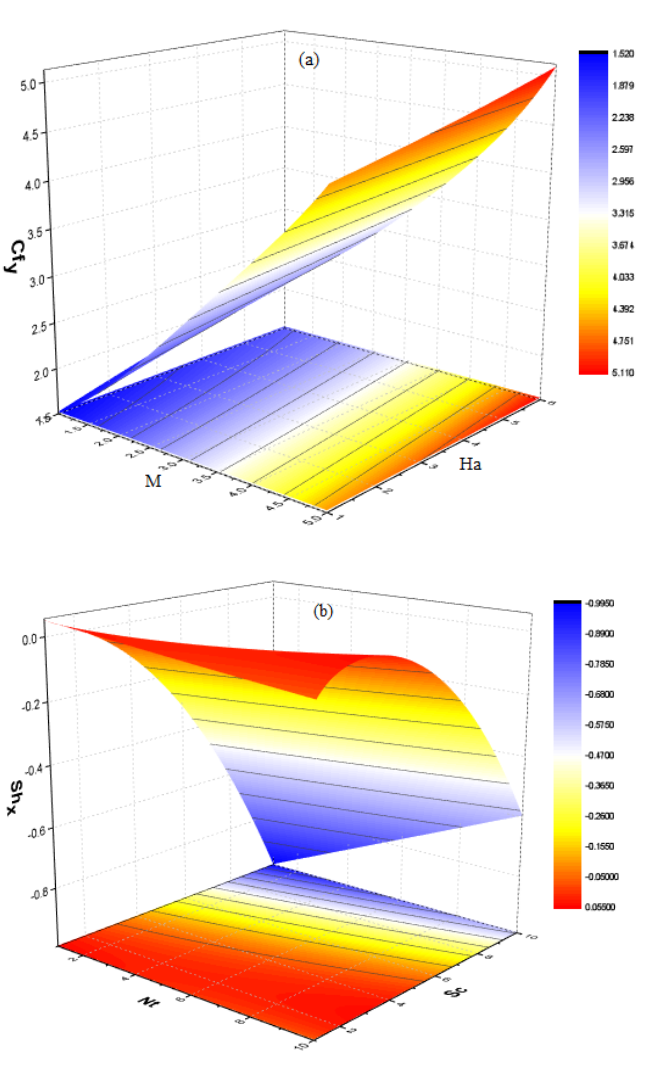
Figure 22. ( a ) Influence of Ha on skin friction. ( b ) Influence of Sc on Sherwood number. Mathematics 2023 , 11 , x FOR PEER REVIEW Figure 22. ( a ). Influence of 𝐻𝑎 on skin friction. ( b ) Influence of 𝑆𝑐 on Sherwood number.